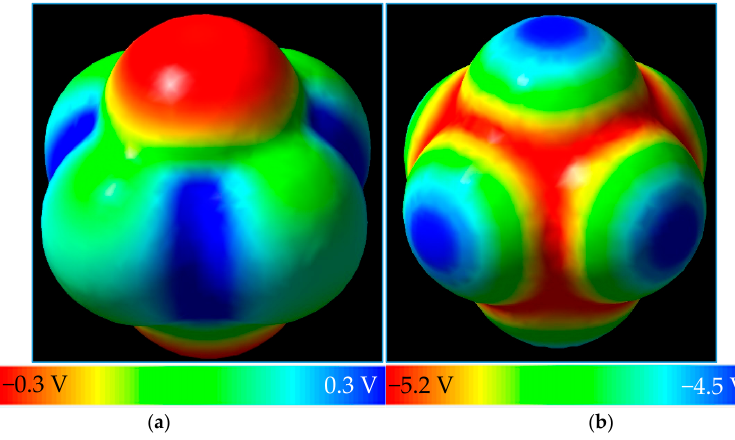
Figure 4. ( a ) PF 6 around its C 4 axis with MEP surface color-coded on the isodensity surface of 0.0004 e/bohr 3 ; and ( b ) the PF 6 − anion and its MEP surface plotted on the electron density surface of 0.0004 e/bohr 3 .